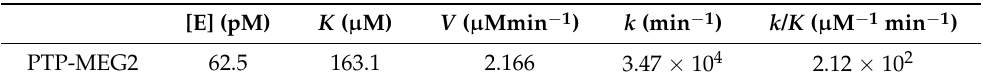
Table 1. Kinetic constants for 6,8-difluoro-4-methylumbelliferyl phosphate (DiFMUP )hydrolysis by PTP-MEG2. Kinetic constants of PTP-MEG2 for measuring enzyme activity were determined using DiFMUP as a fluorogenic PTP substrate.